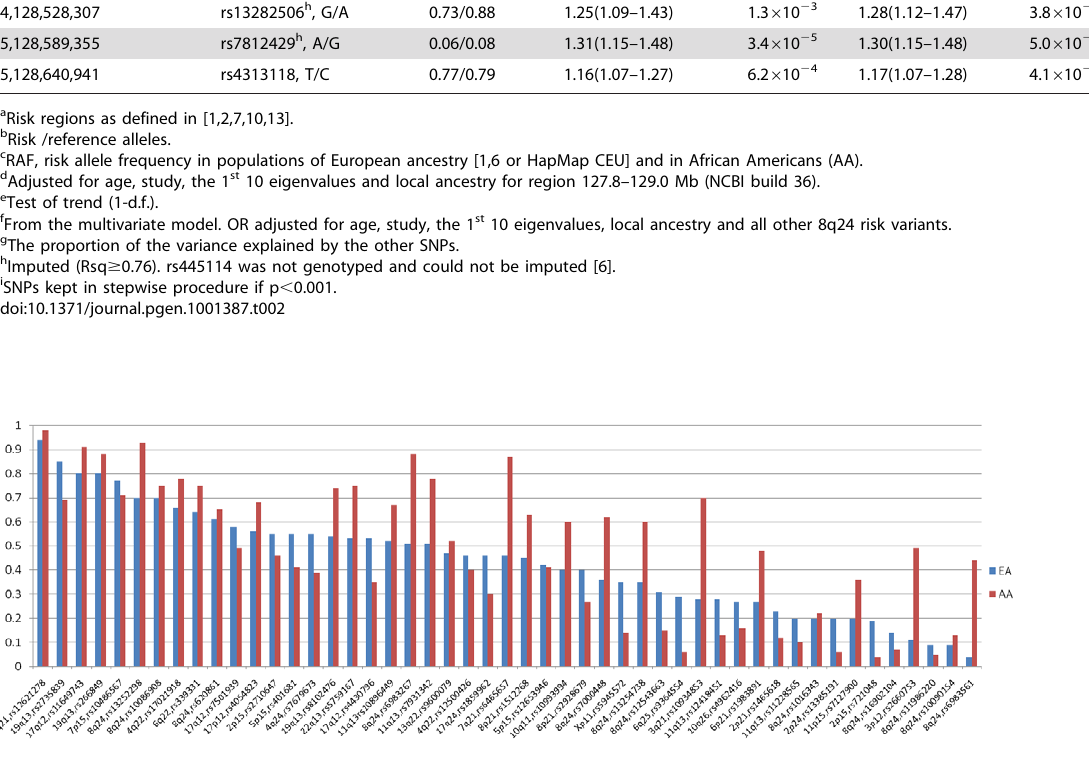
Figure 1. Risk Allele Frequencies in Europeans and African Americans. The distribution of risk allele frequencies (RAF) for the 49 index SNPs (from Table 1 and Table 2) in Europeans (EA) and African Americans (AA). The variants are sorted based on the RAF in